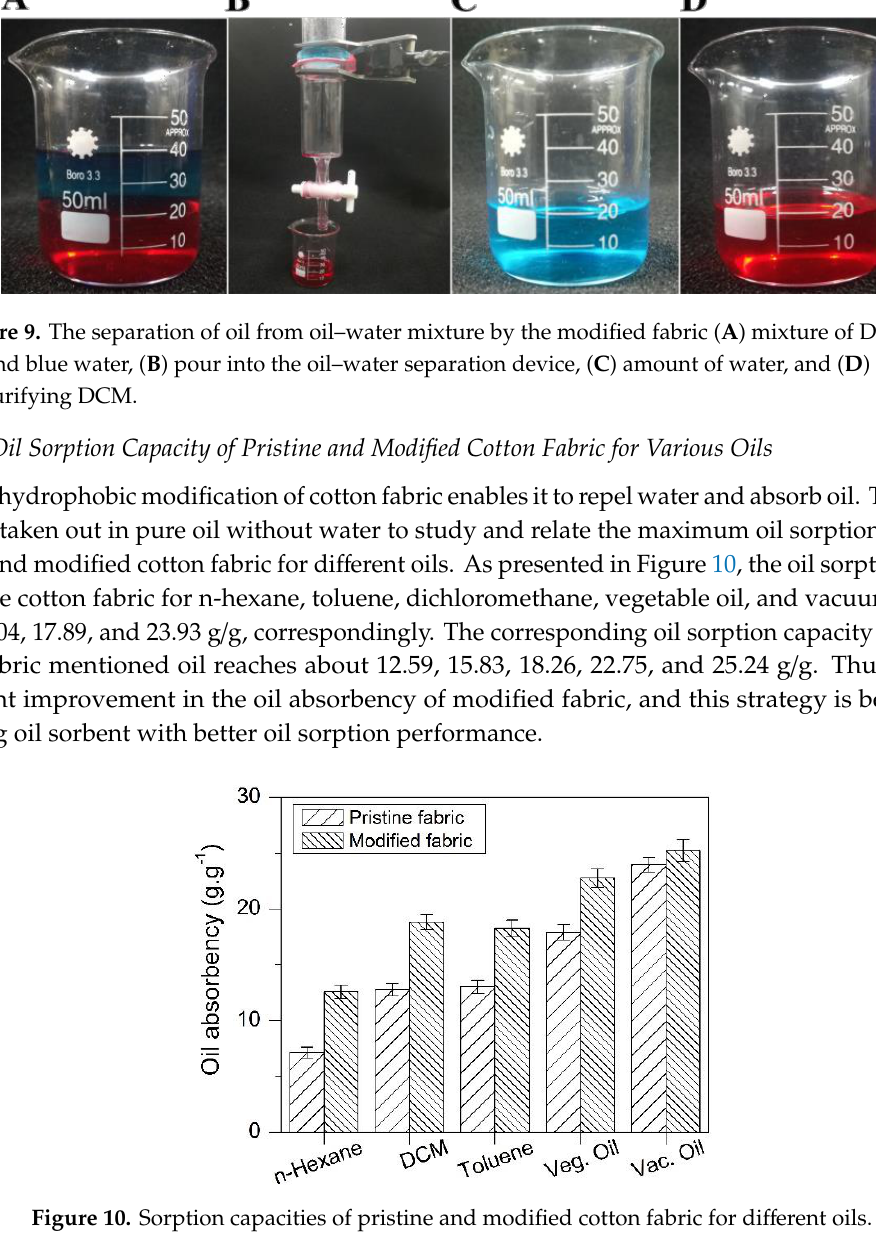
Figure 8 . The modified cotton fabric absorbed underwater dichloromethane (DCM) droplets ( A ) DCM drops in the bottom of the water ( B ) modified fabric dipped into the solution ( C ) absorbing the DCM from the water bottom ( D ) DCM absorbed by the modified cotton fabric.